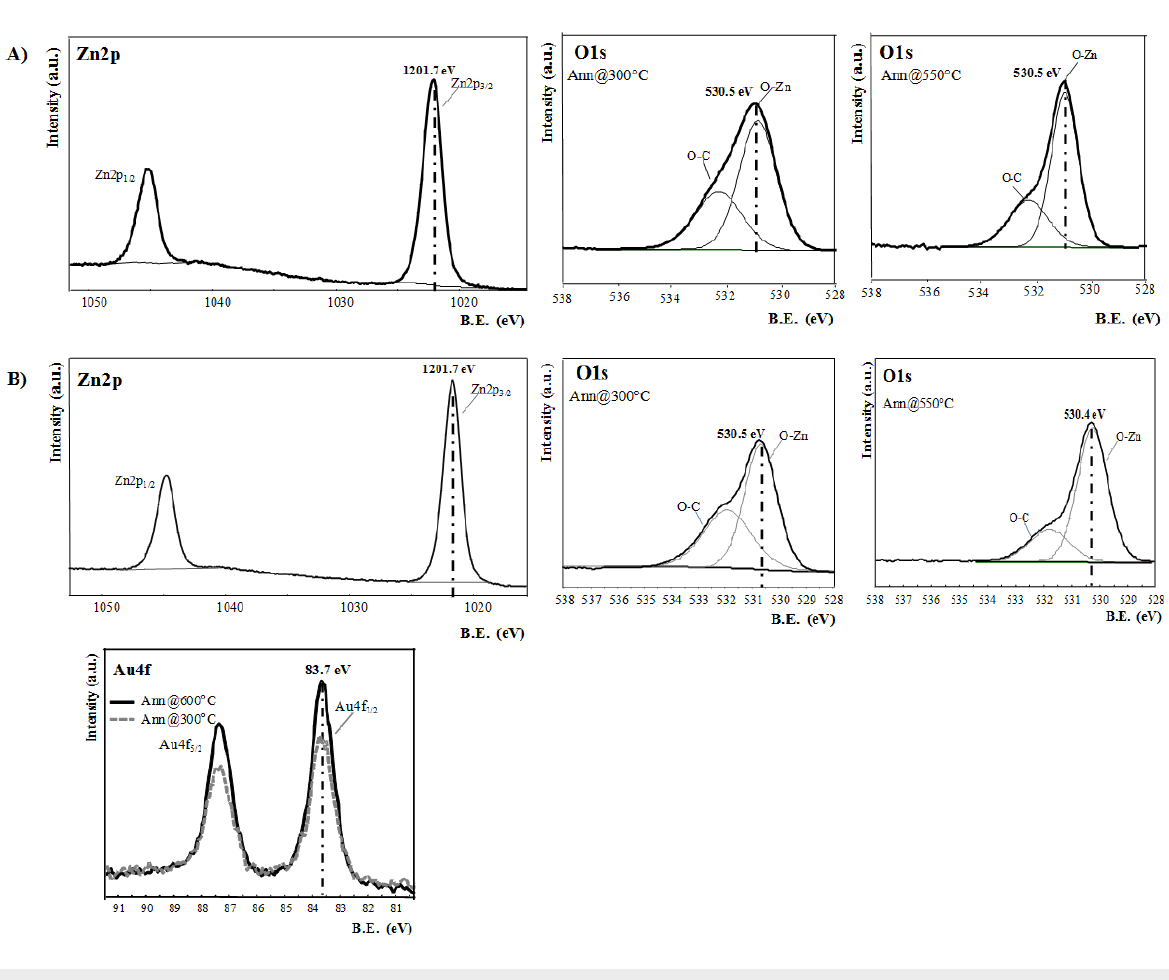
Figure 2: A) XPS spectra of the chemical elements in pristine ZnO: Zn 2p spectrum and O 1s spectra, deconvoluted in two components (O–Zn and O–C), of ZnO annealed at 300 and 550 °C. B) XPS spectra of the chemical elements in hybrid Au@ZnO: Zn 2p spectrum, and Au 4f and O 1s spectra, the last deconvoluted in the two components, after annealing at 300 and 550